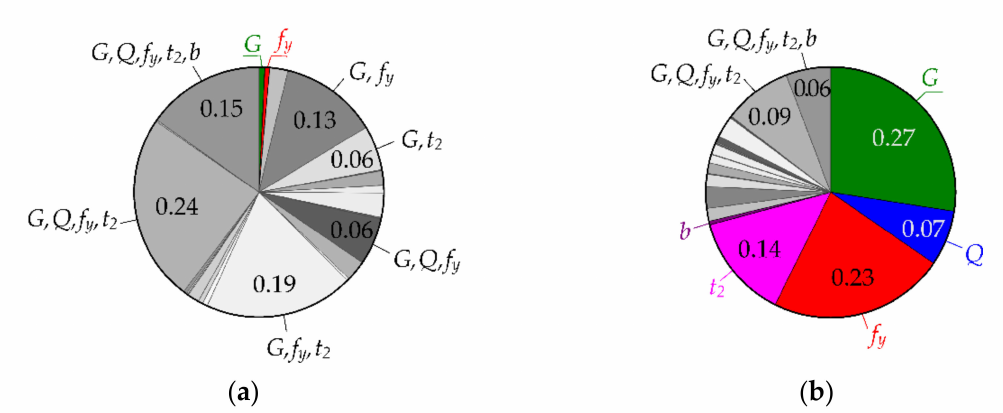
Figure 8. The results of SA for P f = 4.8 × 10 − 4 using: ( a ) C M ( P f ), Equation (23); ( b ) E M ( P f ), Equation (25).